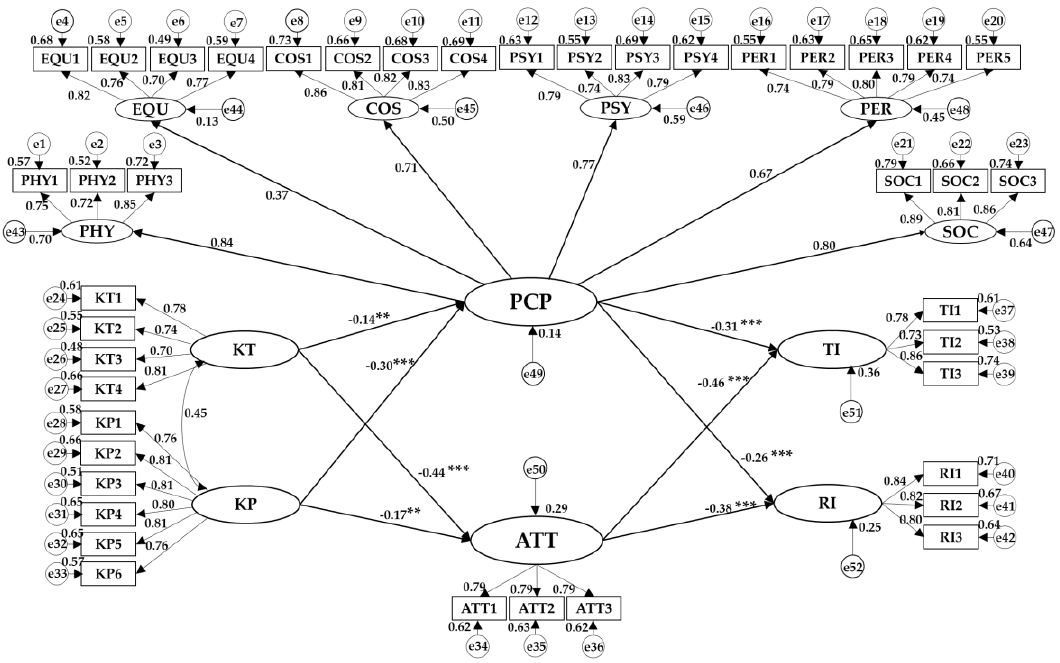
Figure 6. Structure Equation Model Diagram. Note 1. TI = Travel Intention, RI = Recommend Intention, KP = Knowledge of Pneumonia, KT = Knowledge of Tourism, ATT = Attitude to risk aversion, PCP = Perception of risk, PHY = Physical risk, EQU = Equipment risk, COS = Cost risk, PSY = Psychological risk, SOC = Social risk, PER = Performance risk.